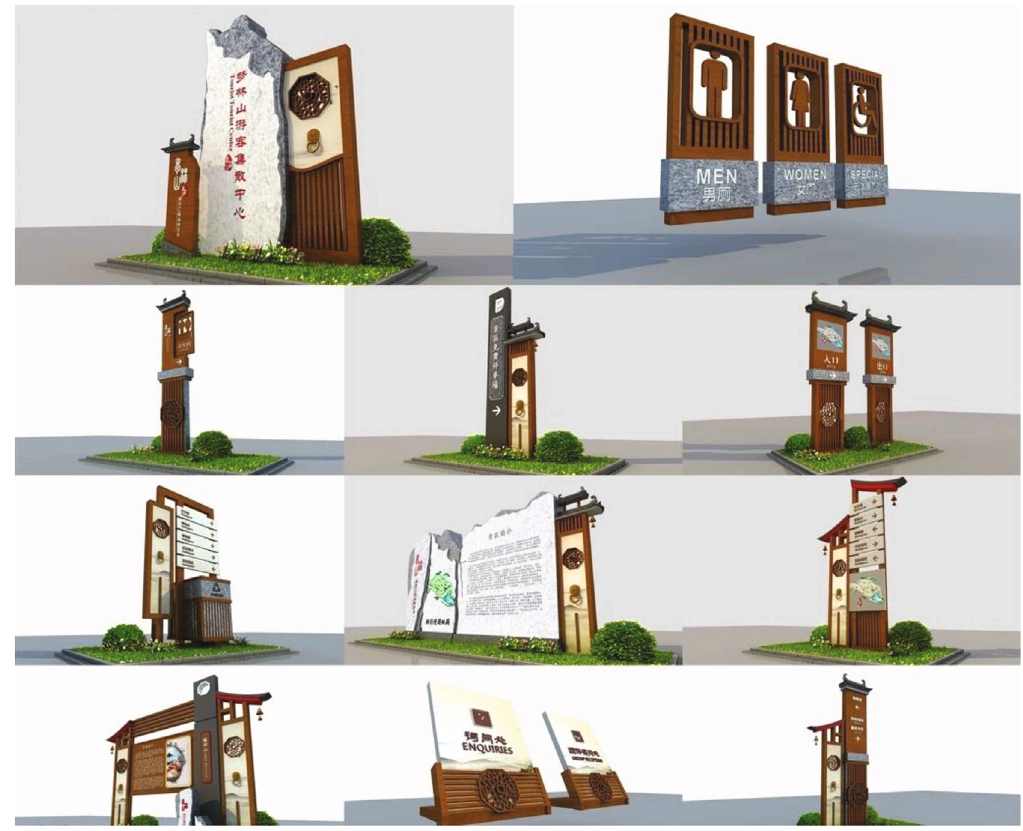
Figure 7: Indoor guidance system design. Table 1: The brand image of ancient “ Fu Lu Shou ”